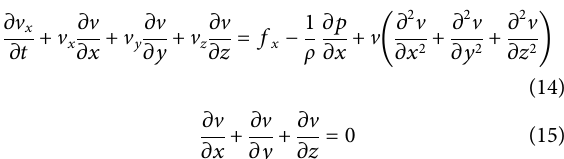
FIGURE 2 Unidirectional fl ow of the grout in an inclined